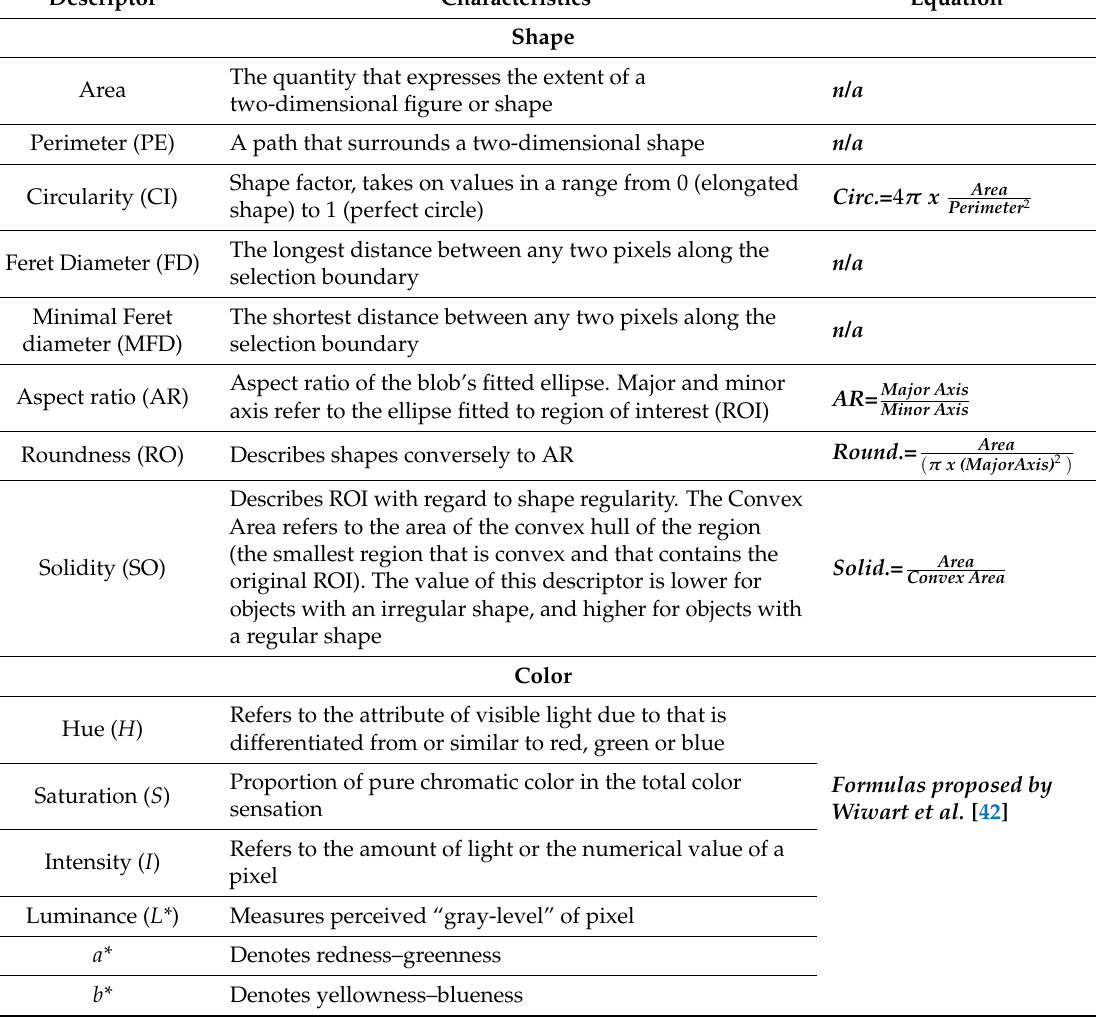
Table 1. The characteristics of the main shape and color